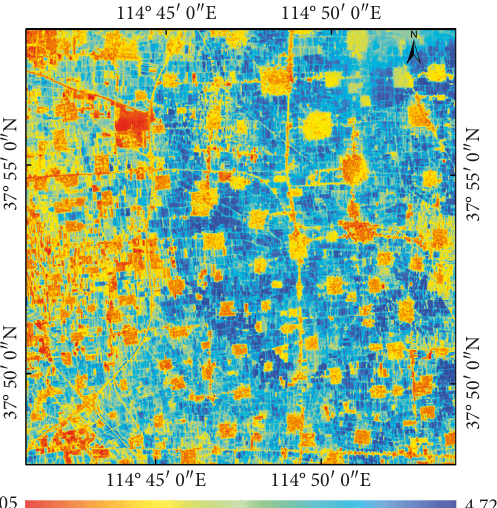
Figure 4: Vegetation water content image based on Landsat-8 data.